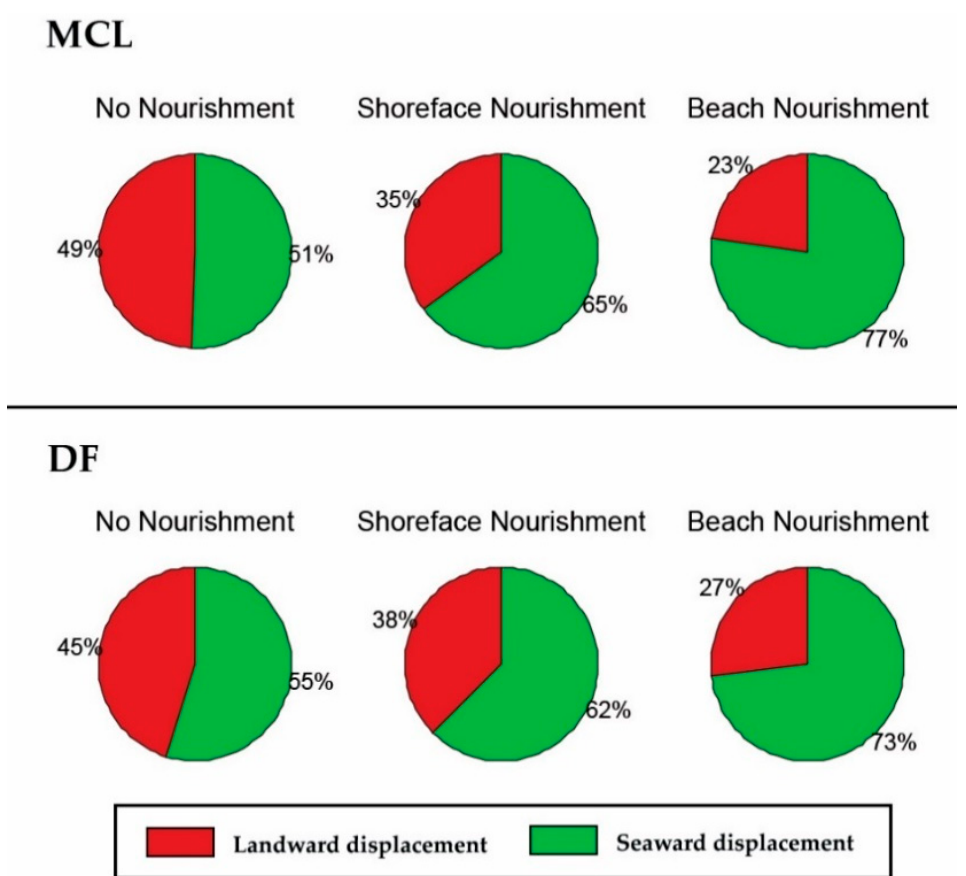
Figure 7. Effects of no nourishments, shoreface, and beach nourishments on MCL ( upper panel ) and dune foot (DF) ( lower panel ) indicators. The red color represents the probability of a landward displacement of the indicator, whereas a green color represents the probability of a seaward displacement. Values indicate the mean values of the distributions.